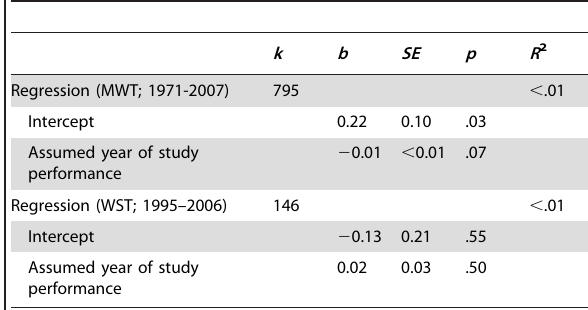
Table 2. Weighted Regression of Assumed Year of Study Performance on Within-Study